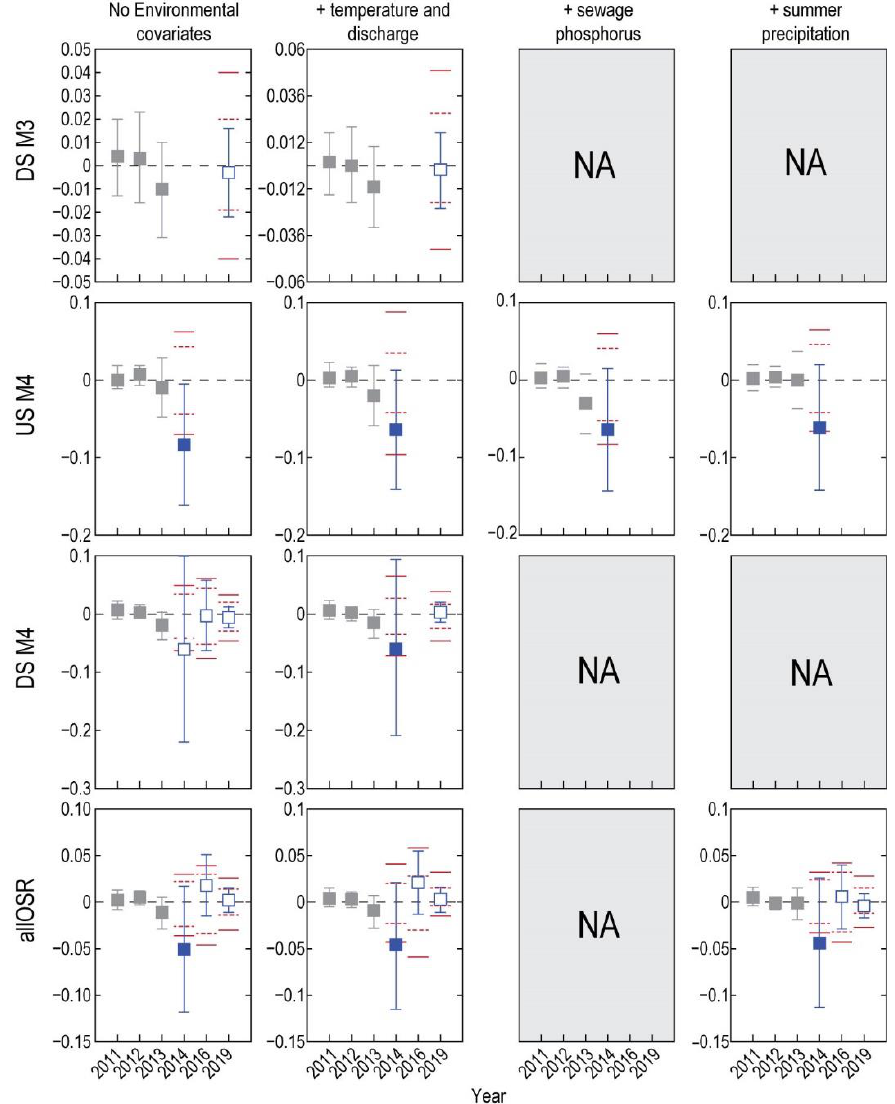
Figure 7. Median residual body weight (BW) of male white sucker (±log10; g) from site-specific regressions done without environmental covariates, with T and D, with T, D, and P, and either T, D, P, and Pr, or T, D, and Pr; “NA” indicates a non-applicable analysis; upper and lower dashed horizontal red lines denote 97.5 and 2.5 percentiles, respectively; upper and lower solid horizontal dashed lines denote outer tolerance limits for the 97.5 and 2.5 percentiles, respectively; error bars in observed test and reference data show 95% confidence intervals; solid symbols suggest a potentially relevant difference; open symbols show potentially irrelevant differences; solid grey symbols denote baseline years (2011–2013) used to derive thresholds used for test years (2014, 2016, 2019).